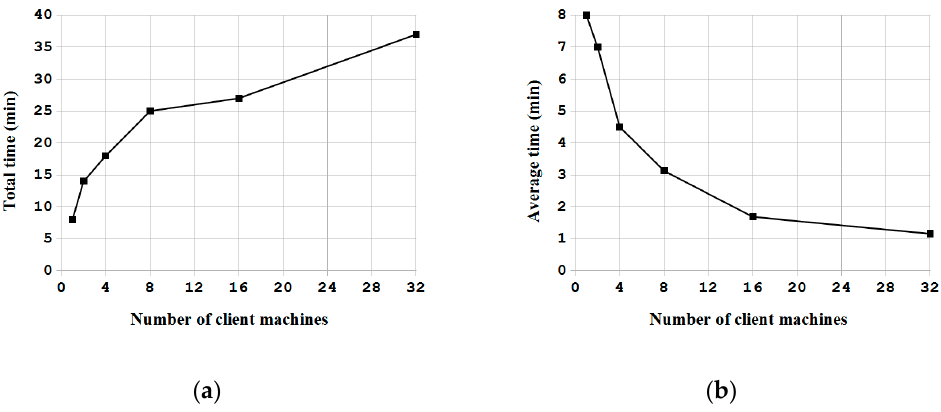
Figure 7. ( a ) Total time and ( b ) average time being required for deploying various numbers of computers using the multicast mechanism.